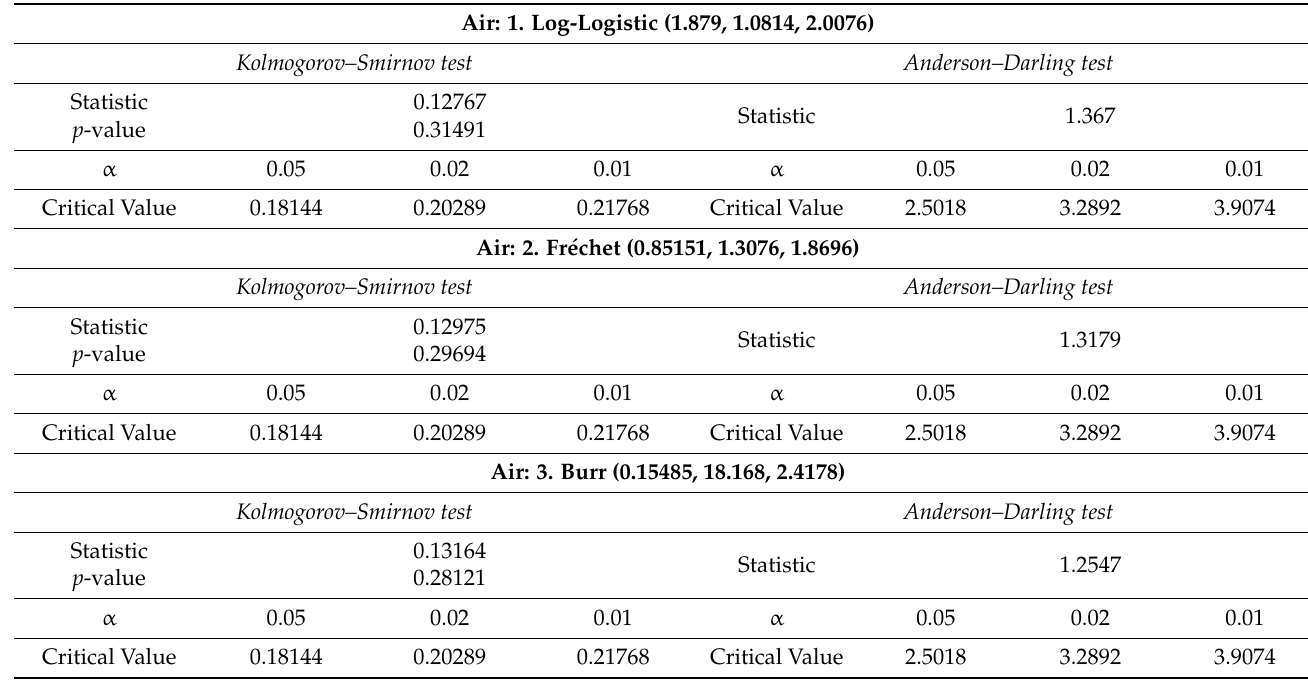
Table 8. Details of the goodness-of-fit tests for the alloy